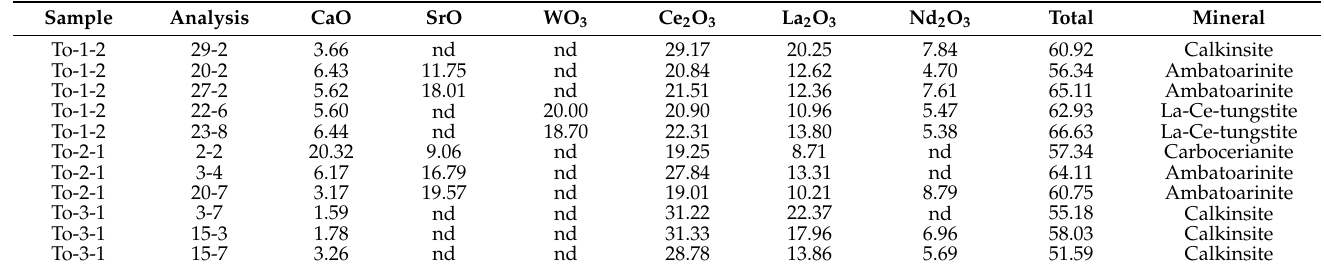
Table A3. Composition of REE carbonates (all values in %; nd—not detected).